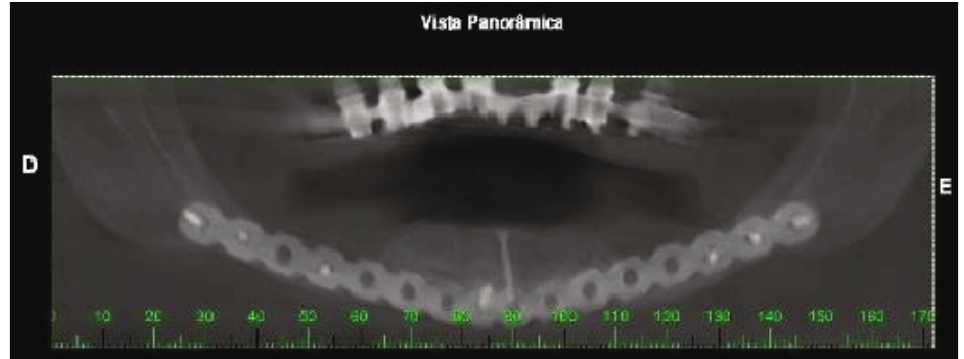
Figure 7: Postoperative panoramic radiography (6 months) demonstrating increased bone height.